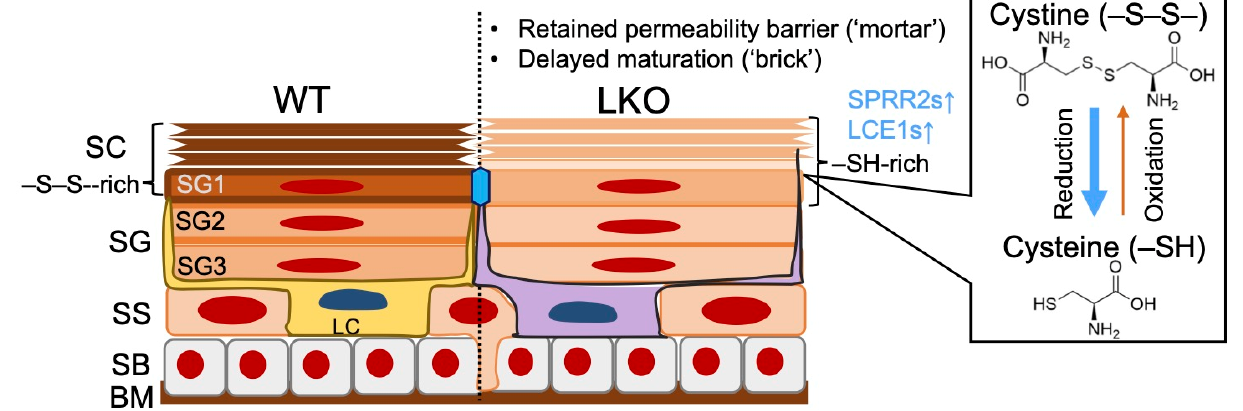
Figure 1. Schematic representation of loricrin-knockout (LKO) epidermis. A thiol (-SH) gradient through the epidermis provides unparalleled cytoprotection, and cornification involves prompt and organized disulfide (–S–S–) cross-linkages. Loricrin is a major effector of cornification, and differentiated layers of LKO epidermis are mechanically compromised despite the presence of other components, such as small proline-rich proteins 2 (SPRR2s) and late cornified cell envelope proteins 1 (LCE1).